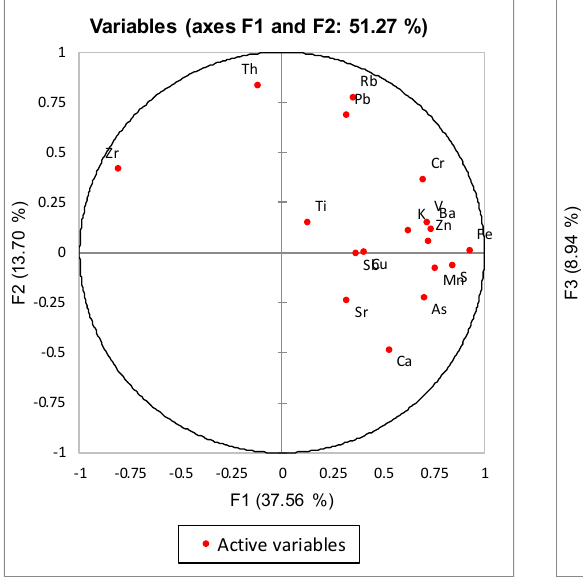
Figure 5. Cochran’s C test. Samples from B horizon, pXRF data. The C test detects one exceptionally large variance value at a time.